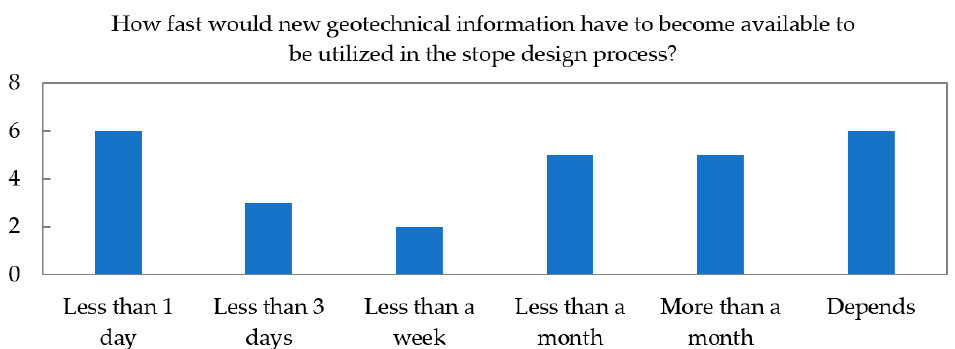
Figure 16. Number of responses on the tolerable time for measurement data to become available for stope design.